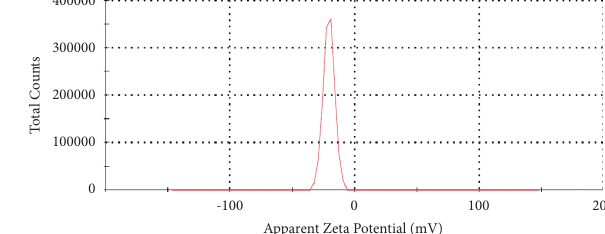
Table 2: Summary of FTIR spectra.